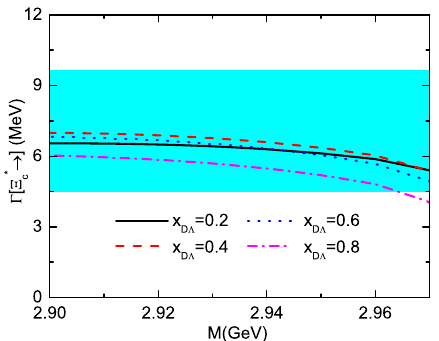
Fig. 6 Partial decay widths of (cid:2) c ( 2923 ) 0 → (cid:3) + c K − (red solid line) and (cid:2) c ( 2923 ) 0 → (cid:2) c π (blackdashline)with J P = 1 / 2 − asafunction of the parameter X D (cid:3) . The cyan bands denote the experimental total width [2]